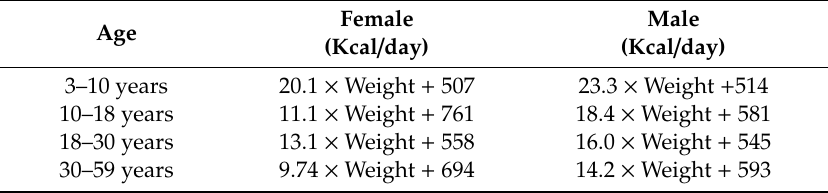
Table 1. Resting energy expenditure (REE) predicted by the Oxford